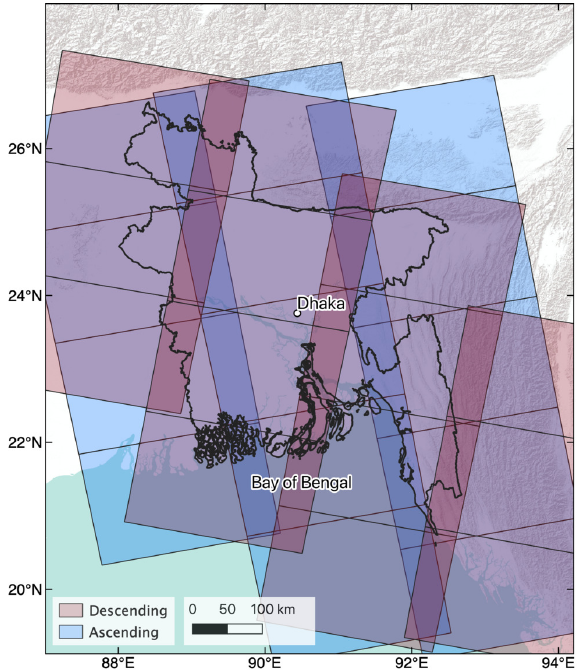
Figure 2. Coverage of Sentinel-1 ascending and descending tracks in Bangladesh overlaid on a shaded relief map. The black line delineates the boundary of Bangladesh. Shaded relief map from Esri